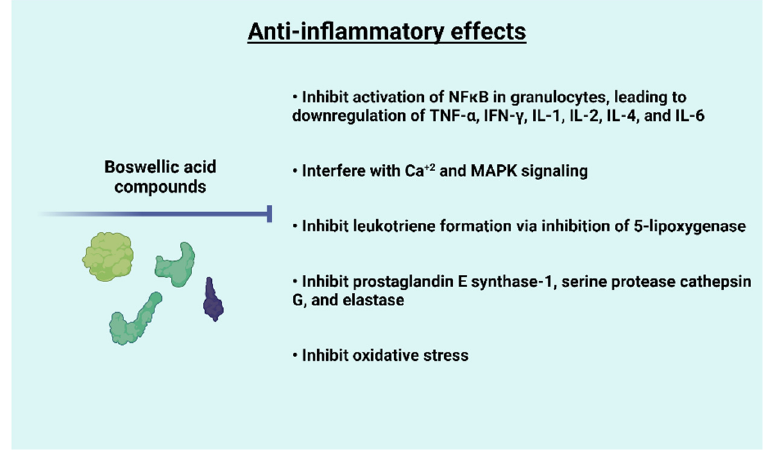
Figure 5. Schematic diagram showing anti-inflammatory effects of boswellic acids and Boswellia ex- tracts.